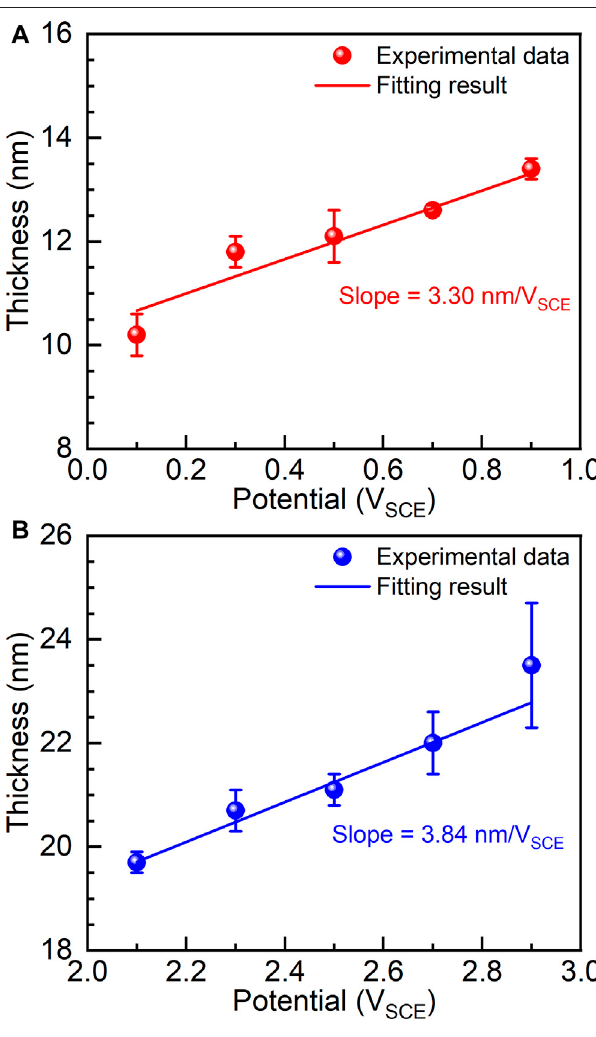
FIGURE 8 | Thicknesses of passive fi lms formed on as-cast Ti-6Al-4V under different fi lm formation potentials, (A) fi lms formed between 0.1 V and 0.9 V and (B) fi lms formed between 2.1 V and 2.9 V.